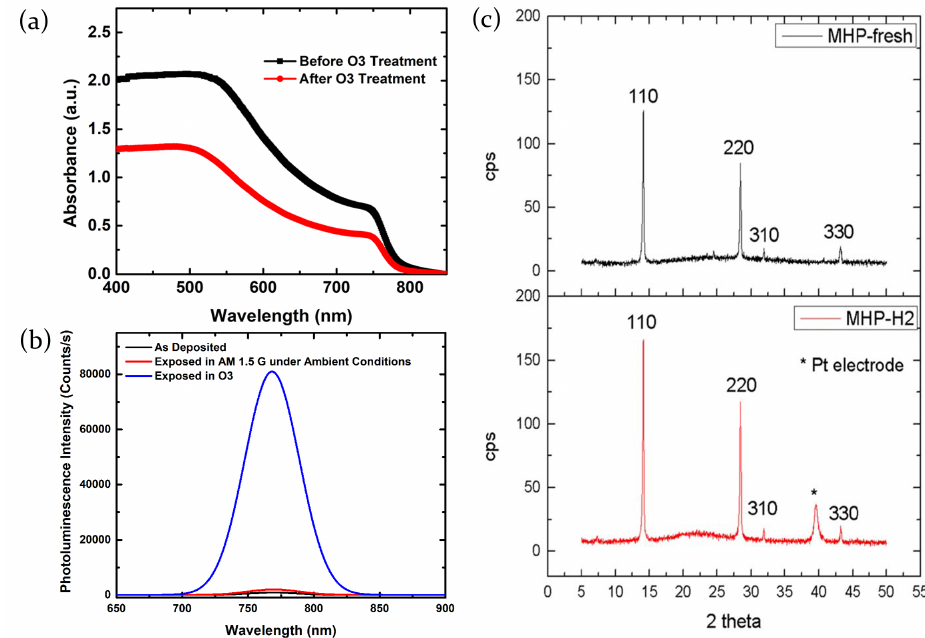
Figure 14. ( a ) UV–Vis absorption measurements before and after O 3 exposure for MAPbI 3 − x Cl x perovskite films. ( b ) PL spectra of the pristine (black line), Solar A.M. 1.5G exposed (red line) and O 3 exposed (blue line) MAPbI 3 − x Cl x perovskite films. Adapted with permission from [98]. Copyright © 2017, American Chemical Society. https://pubs.acs.org/doi/10.1021/acssensors.7b00761. Further permission should be directed to the ACS. ( c ) XRD patterns of MAPbI 3 − x Cl x films before and after exposure to 100 ppm hydrogen gas, which demonstrate that the perovskite does not change crystal structure after interacting with H 2 . The only different feature noticeable in H 2 -exposed perovskite film relates to the Pt electrode; it is absent in the pristine sample spectra, since the XRD of the non-exposed sample was done on a glass substrate without electrodes. Adapted with